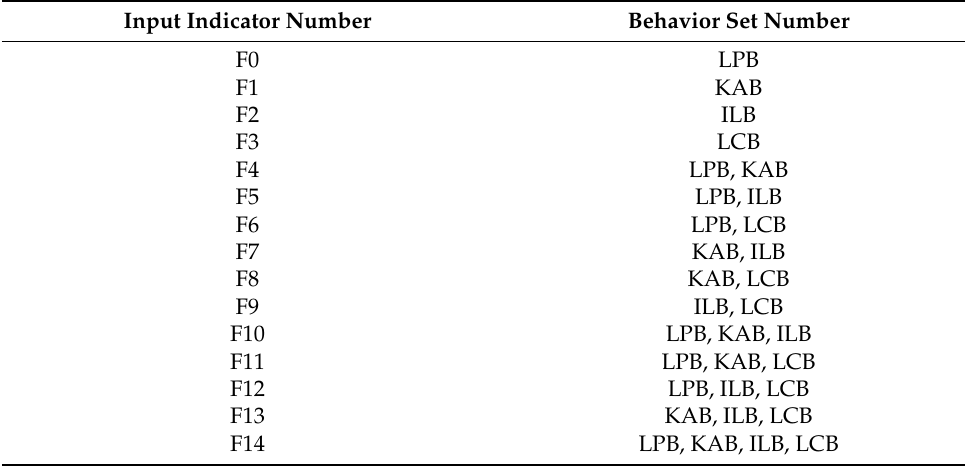
Table 2. Combination of online learning behavior sets.